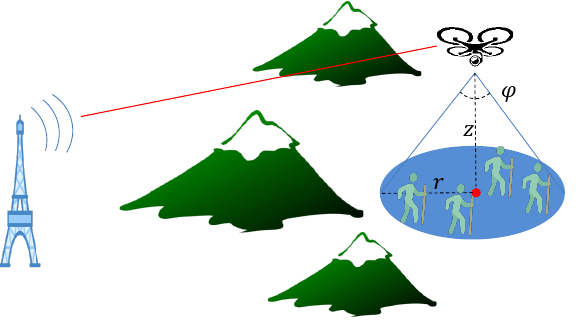
Figure 1. An application of using a flying robot to monitor and support communication for a group of